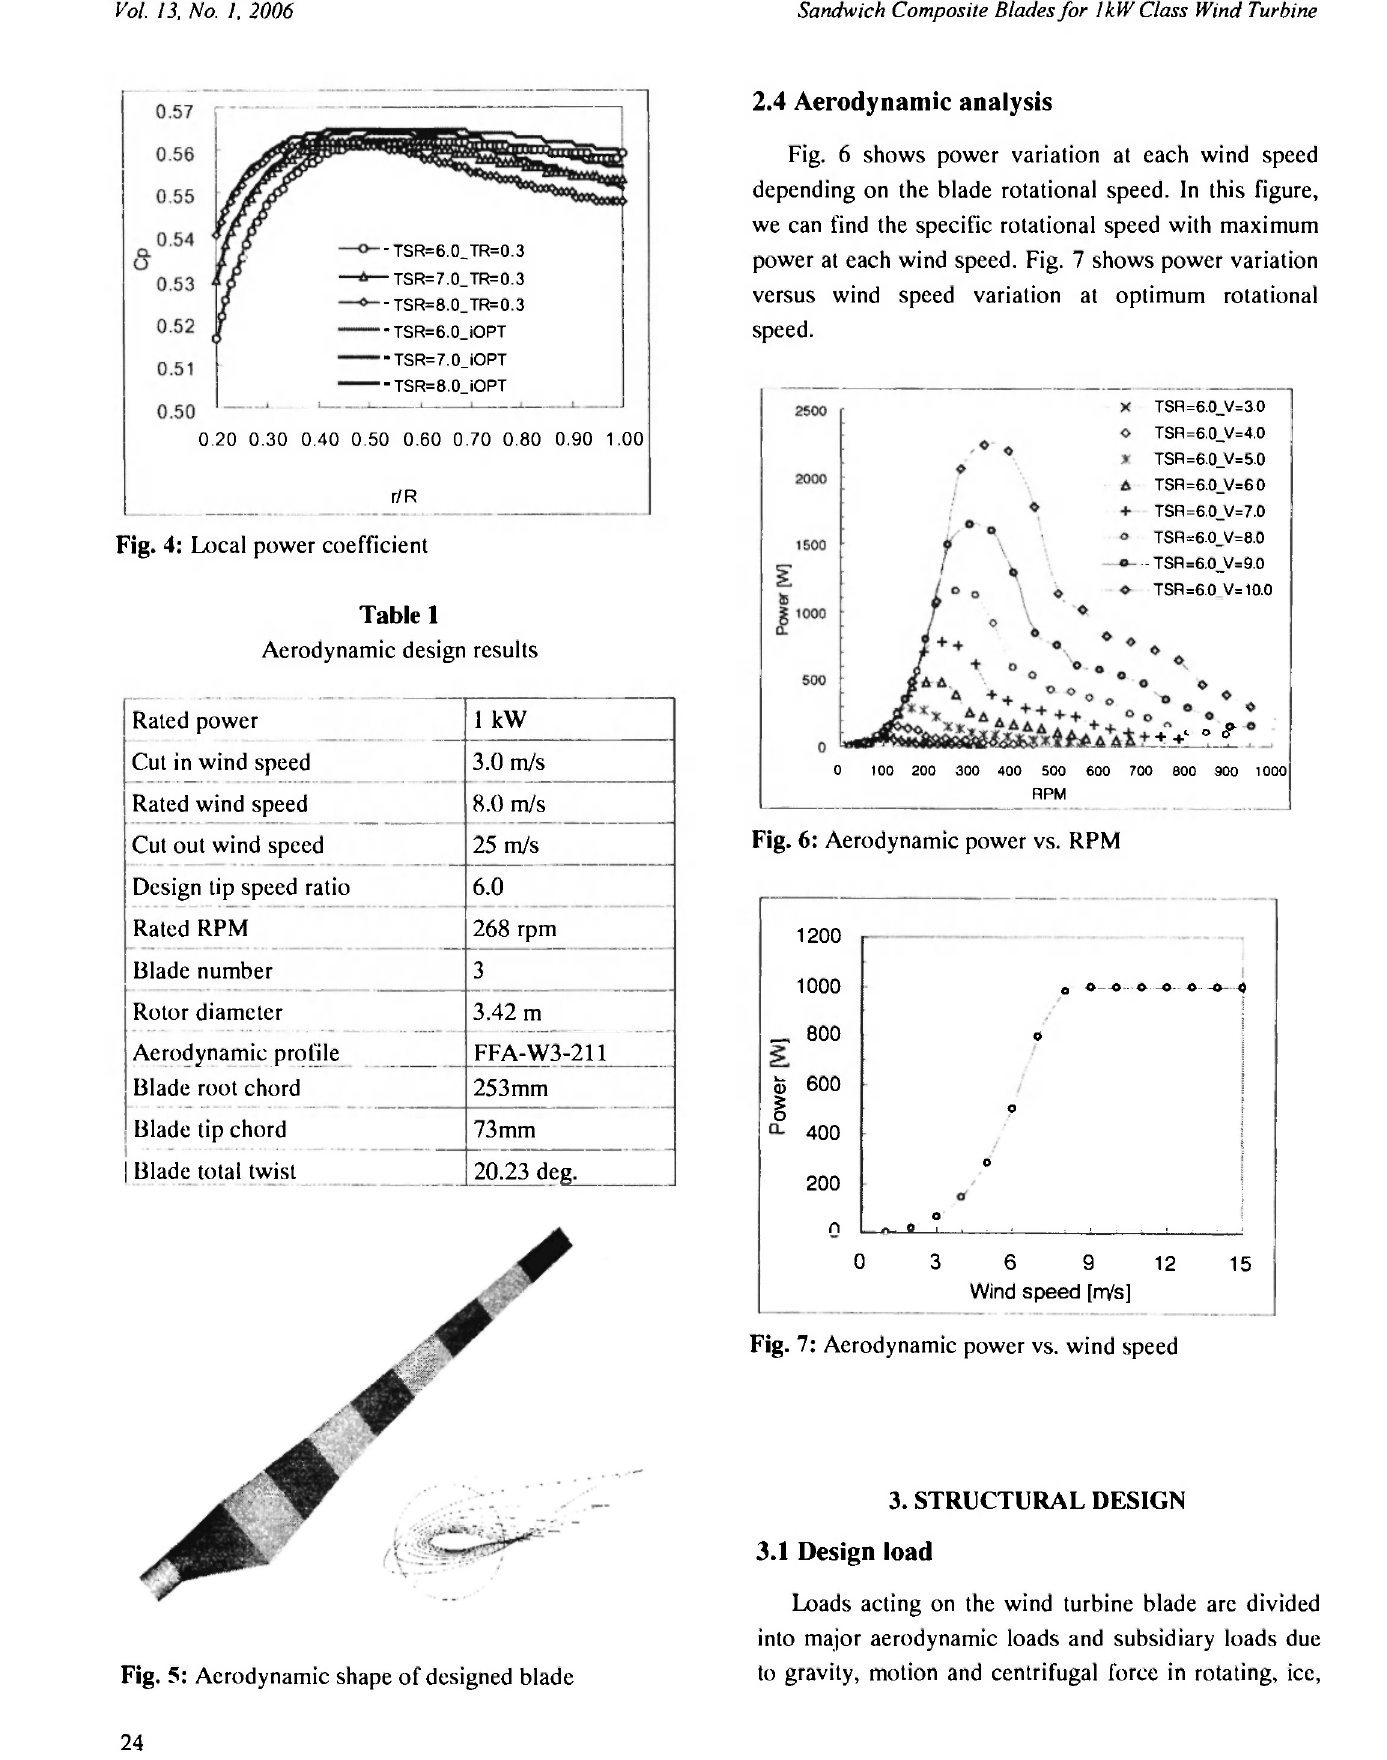
Fig. 5: Aerodynamic shape of designed blade